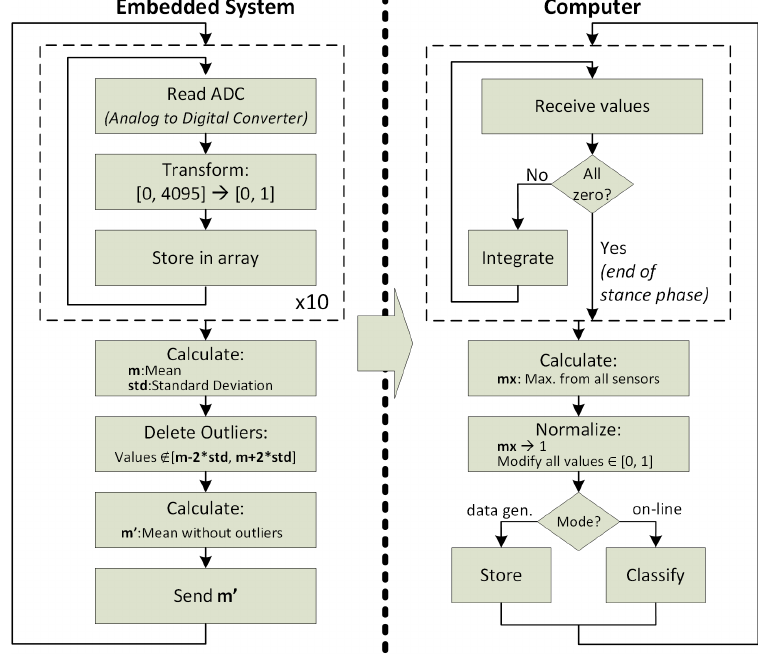
Figure 7. Filtering and Normalization process. ( left ) Embedded system: filtering algorithm for each sensor. ( right ) Computer: normalization algorithm and